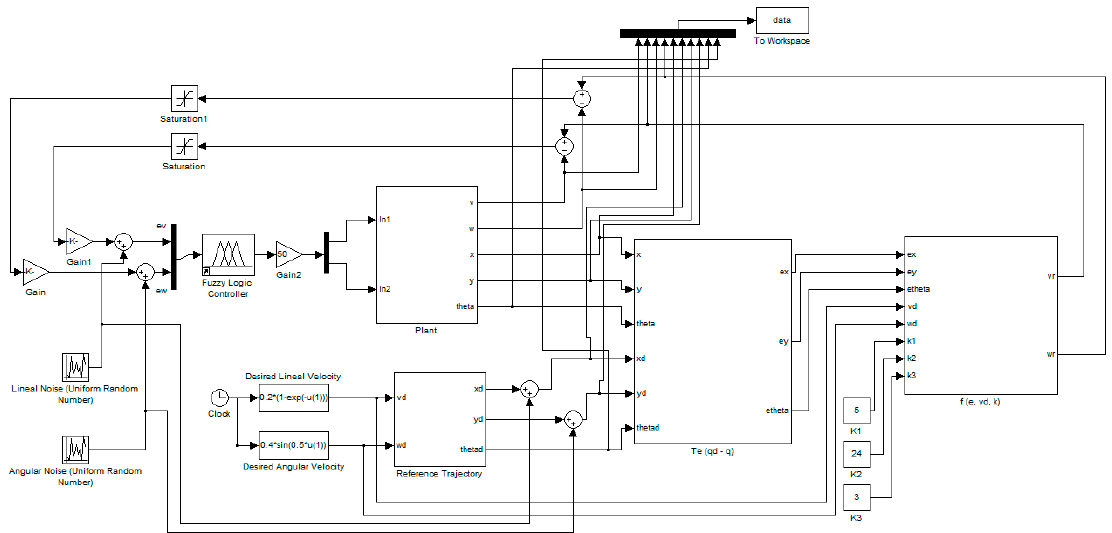
Figure 11. Complex plant for an autonomous mobile robot with noise.